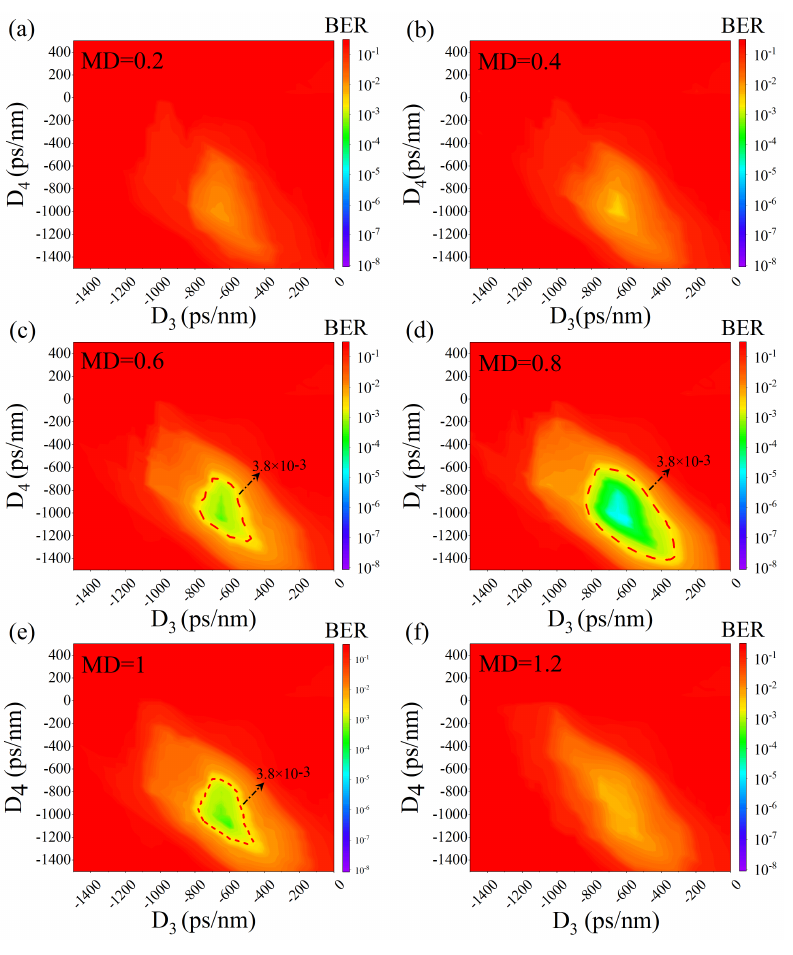
Figure 4. ( a – f ) The contour plot of eavesdropped BER versus dispersion values of D3 and D4 for different phase modulation depths.